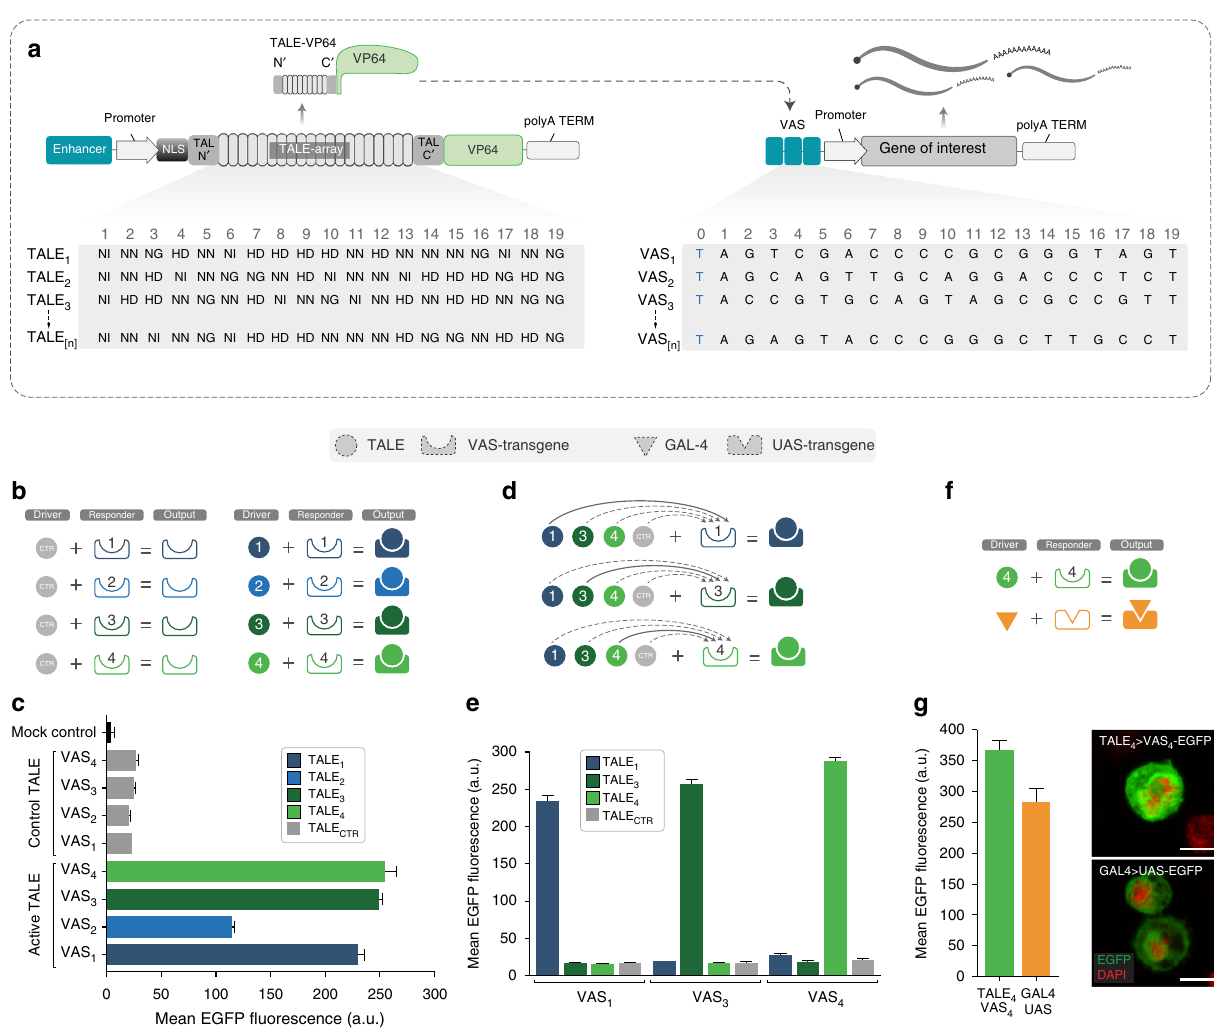
Fig. 1 Design and optimisation of TALE – VAS driver – responder pairs in Drosophila S2 cells. a Schematic representation of the TALE – VAS system. TALEs consist of a N-terminal domain (TAL N ′ ) containing a nuclear localisation sequence (NLS), a custom TALE-array, and the C-terminal domain (TAL C ′ ) fused to a transcription activation domain (VP64). Each repeat within the TALE-array recognises a speci fi c nucleotide depending on the amino acids 12 and 13 of that repeat (NG = T, NI = A, NN = G, HD = C). Transcription of the gene of interest is initiated upon binding of the TALE to its cognate 20 nt long VAS. The invariable 5 ′ T at position 0 is shown in blue. b , c Comparative analysis of reporter expression between four engineered TALE – VAS driver – responder pairs. Diagrams indicate the experimental conditions tested, re fl ecting the drivers used (circles) and their respective responders (shapes with matching indentations) — colours and numbers indicate the four different TALE – VAS pairs ( b ). c Flow cytometry analysis of reporter expression in Drosophila S2 pMT-GAL4 cells. The original backbone TALE plasmid without a TALE-array (TALE CTR ) was used to establish background levels of GFP expression. d , e Speci fi city of transgene activation by TALE drivers. Each VAS responder was co-transfected with TALE 1, 3, 4 drivers and the control TALE in S2 pMT-GAL4 cells ( d ). e Flow cytometry analysis of EGFP reporter induction for each TALE – VAS combination in ( d ). f , g Comparison of TALE – VAS and GAL4 – UAS systems. S2 pMT-GAL4 cells were transfected in parallel with either TALE 4 > VAS 4 -EGFP or GAL4 > UAS-EGFP driver – responder pairs ( f ). Ef fi ciency of transgene expression assessed by fl ow cytometry and confocal microscopy (scale bar = 5 µ m) ( g ). In all cases the mean EGFP fl uorescence was calculated from three biological replicates ( n = 3 from one experiment, mean ± s.d.; a.u. arbitrary